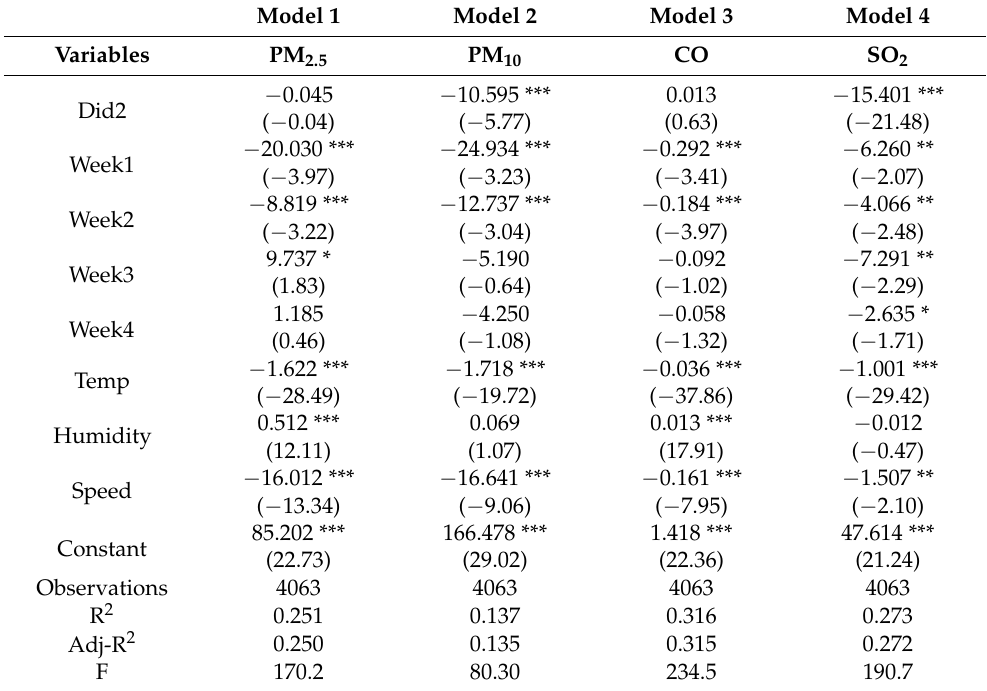
Table 10. Dynamic test